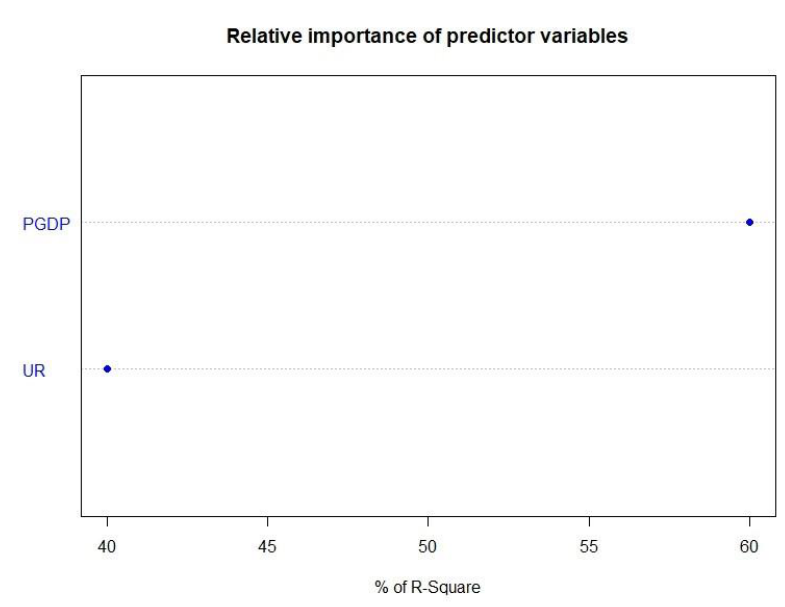
Figure 8. The relative importance of predictor variables.